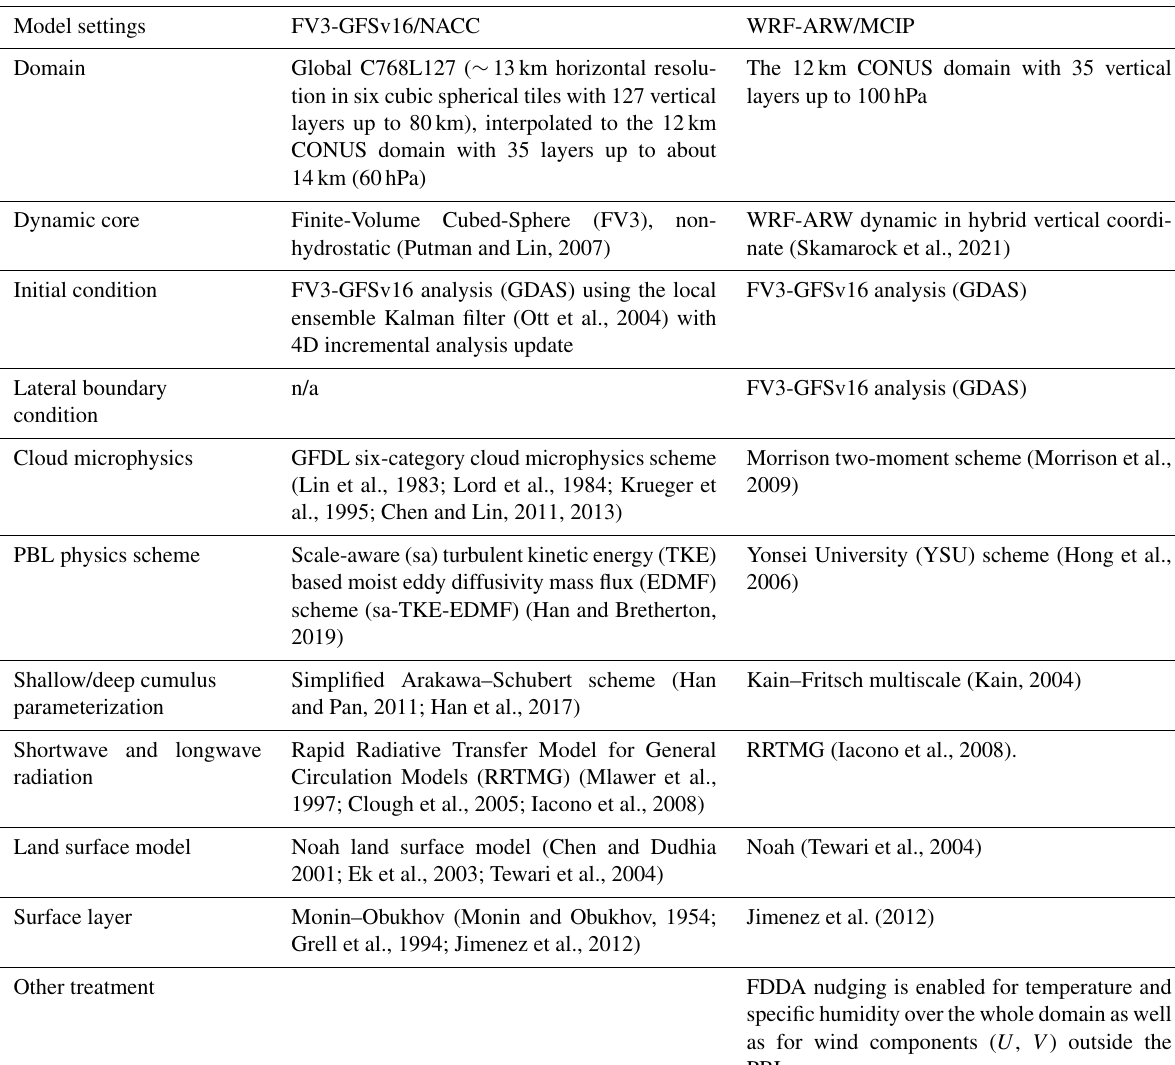
Table 1. The two meteorological datasets used in this